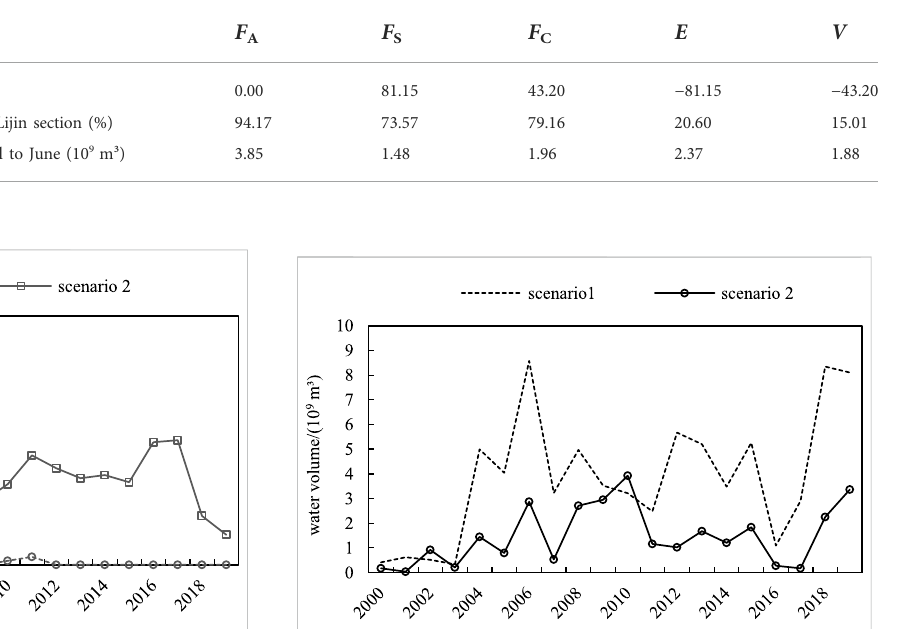
FIGURE 4 Substandard days of ecological base fl ow at the Lijin section in two scenarios.